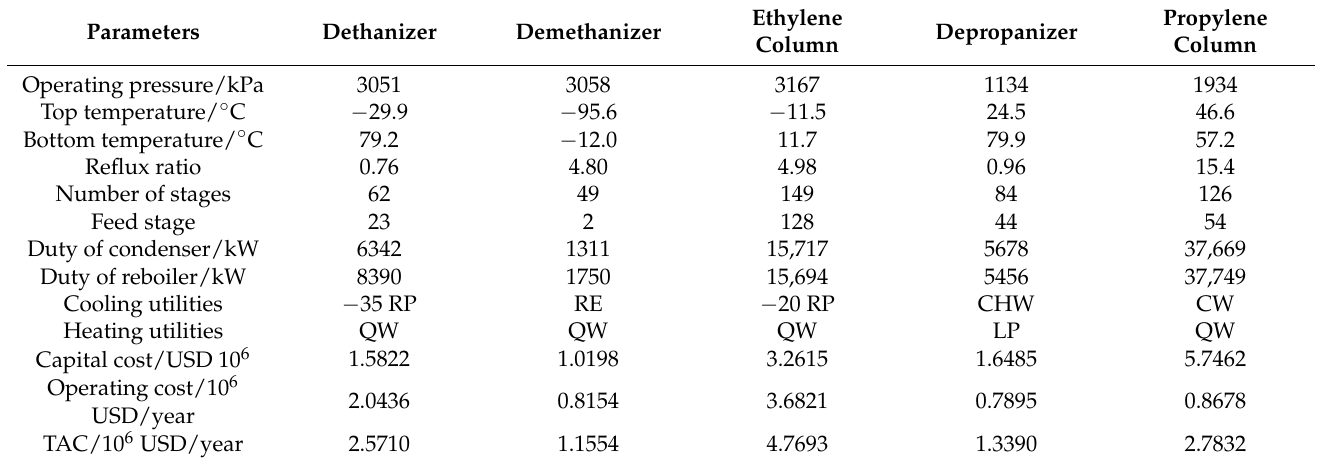
Table 7. Distillation parameters corresponding to the maximum